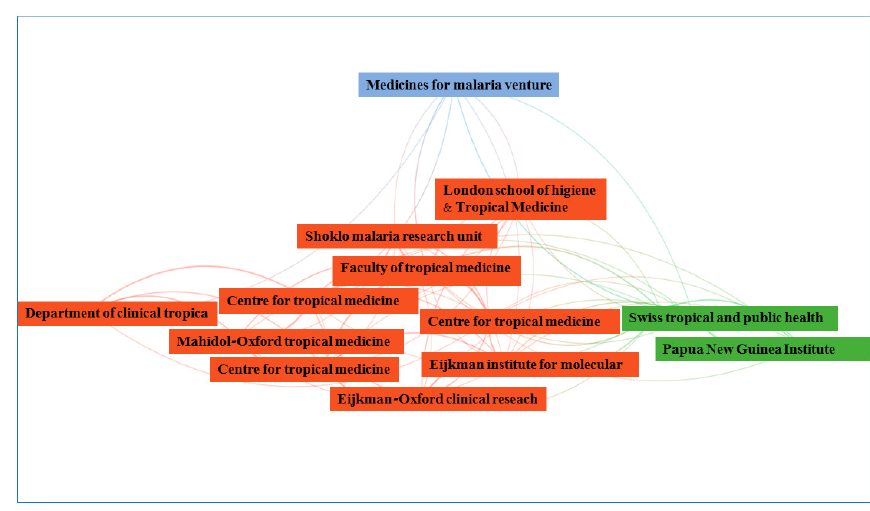
Figure 6. Distribution by communities of the main institutions.